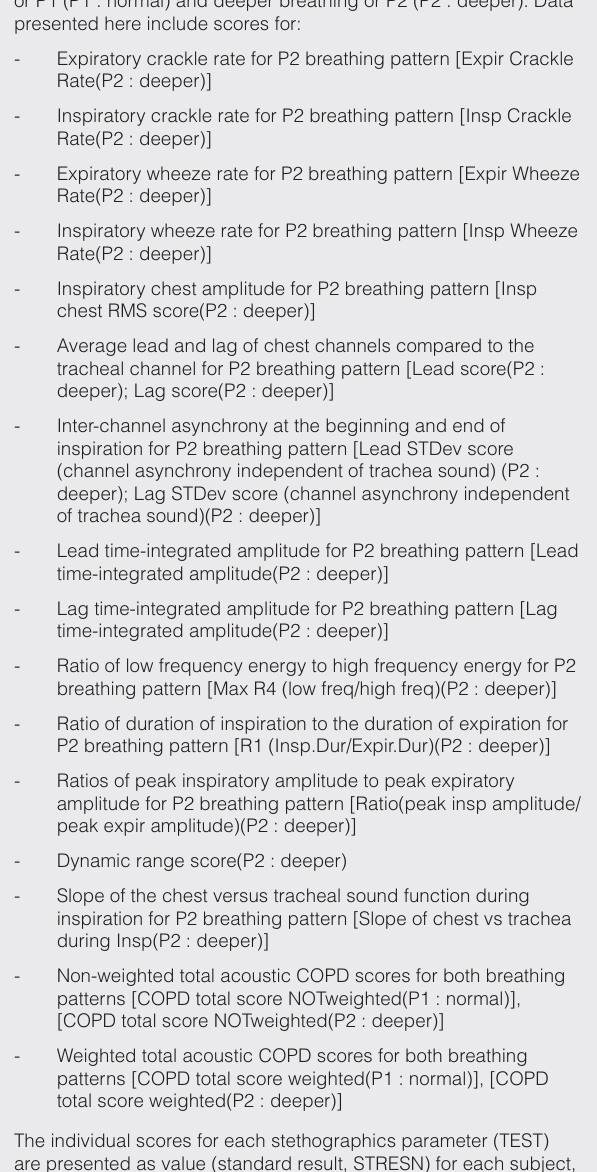
Dataset 5. Stethographics